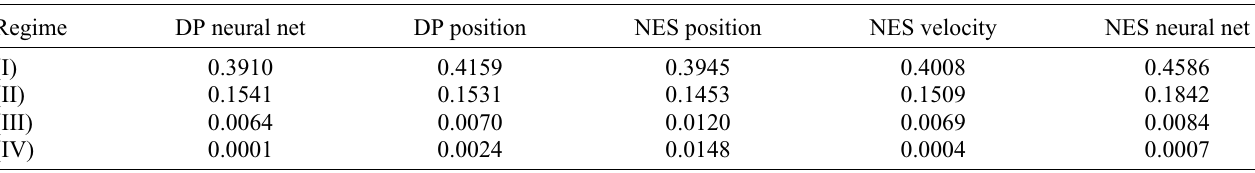
TABLE II. Comparison of the lowest infidelity values between optimizations of AD and NES with respect to different parameteri- zations of the control [position x L ( t ) , velocity v L ( t ) and neural net x L ( t ) = NN θ ( t ) ]. Based on these testing values we determine which parameterizations to use for the optimizations in the main text. These simulations are run for a system size of N = 50 and all the other parameters are the same as the parameters in Fig. 2 in the main